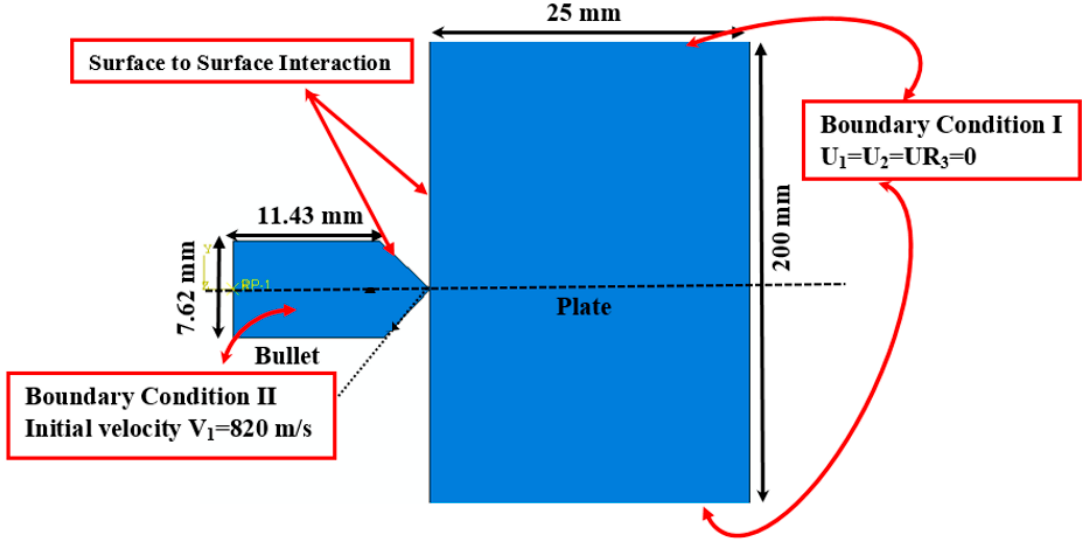
Figure 1. A four-node bilinear plane stress quadrilateral, reduced integration, hourglass control element CPS4R was used for meshing both bullet and plate as shown in Figure 4.